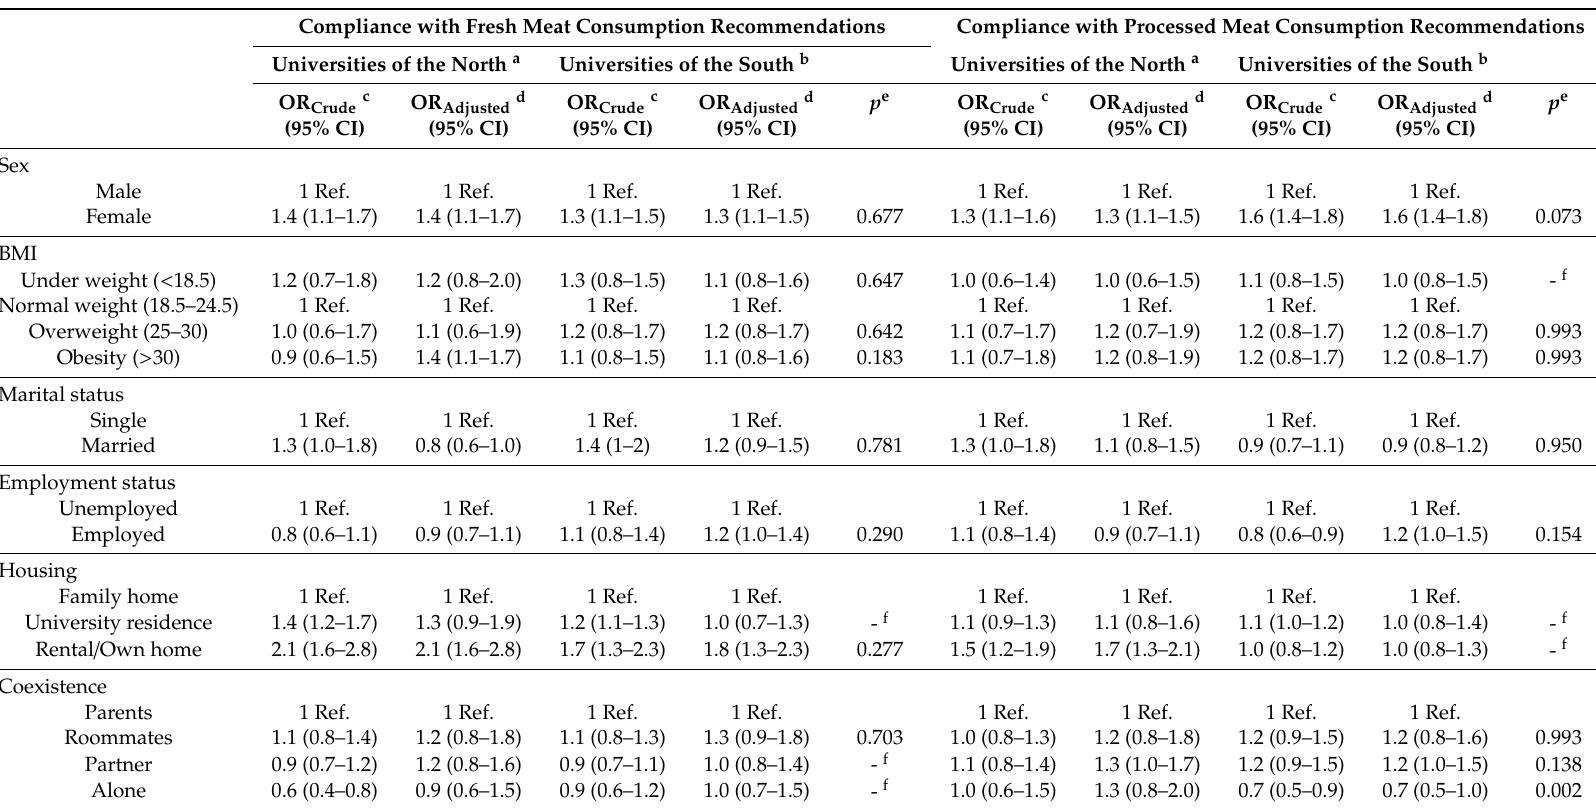
Table 5. Factors associated with compliance with nutritional recommendations in the frequency of consumption of fresh meat and processed meats, according to geographical